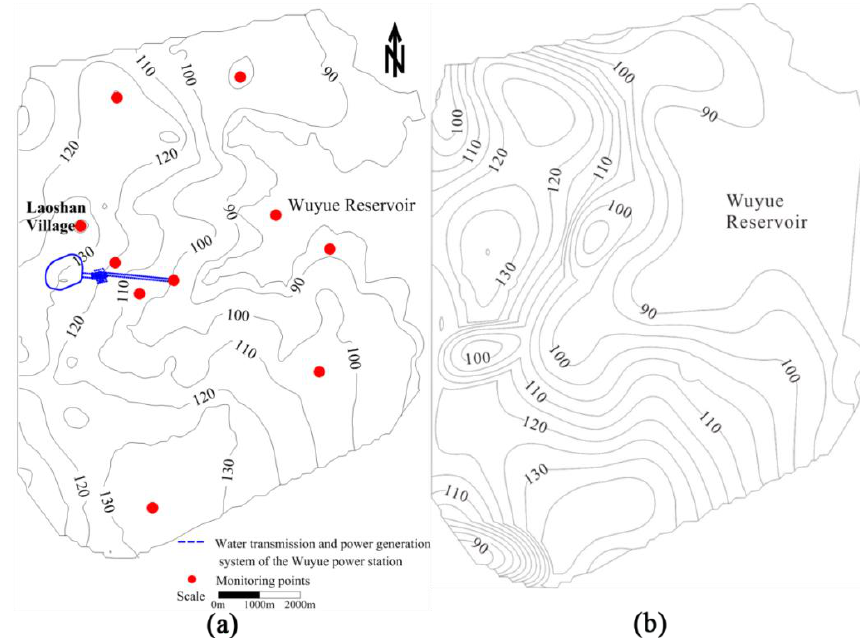
Figure 8. Comparison of ( a ) the natural seepage field and ( b ) the simulated seepage field. The measured and calculated water levels of the monitoring points are shown in Figure 9a. The simulated water level was roughly consistent with the field-measured water level, and the average error of the simulated calculated water level was 1.98%.